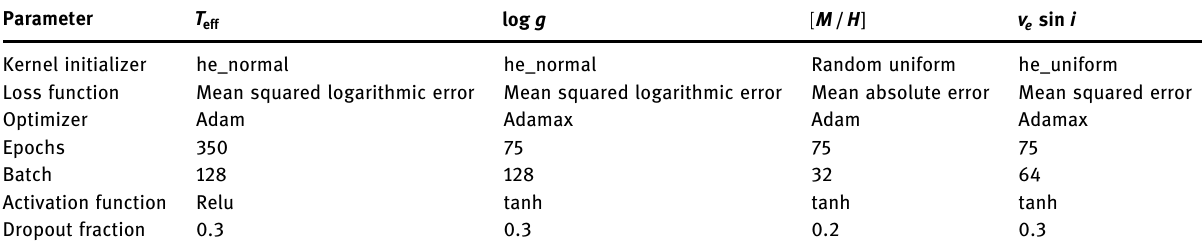
Table 2: Set of parameters used for the four networks, for deriving T eff , g log ,